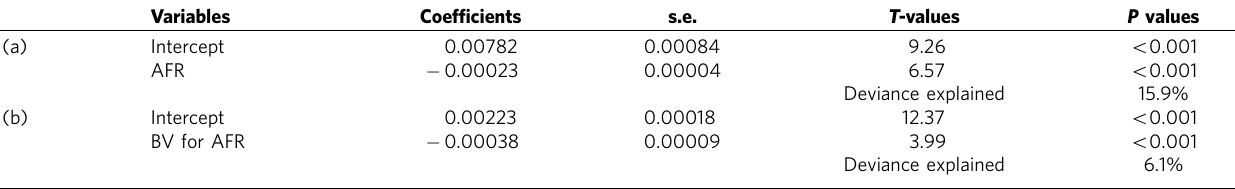
(a) Effects ofage at first reproduction (AFR) and (b) breedingvalues (BV) for age at first reproductionon lifetime individualcontributiontopopulation growth for cohorts of women born in1772–1880 at ıˆle auxCoudres,Canada.Estimatesarefromlinearmixedeffectsmodelsincludingyearofbirthasarandomeffect.ThedeviancesexplainedbyAFRandBVwereestimatedbycomparingmodelswithandwithout the variables of interest. The effects of demographic phases and the interactions between phase and AFR or BVwere not retained in final models (all P 4 0.108), see Supplementary Table 1 for full models.